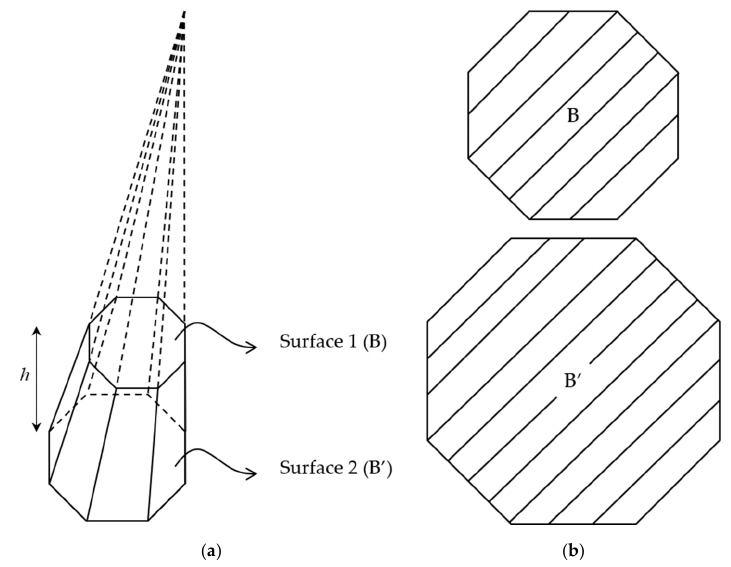
Figure 4. Pyramid: ( a ) Chopped pyramid and ( b ) cross-section of two surfaces B and B ’.